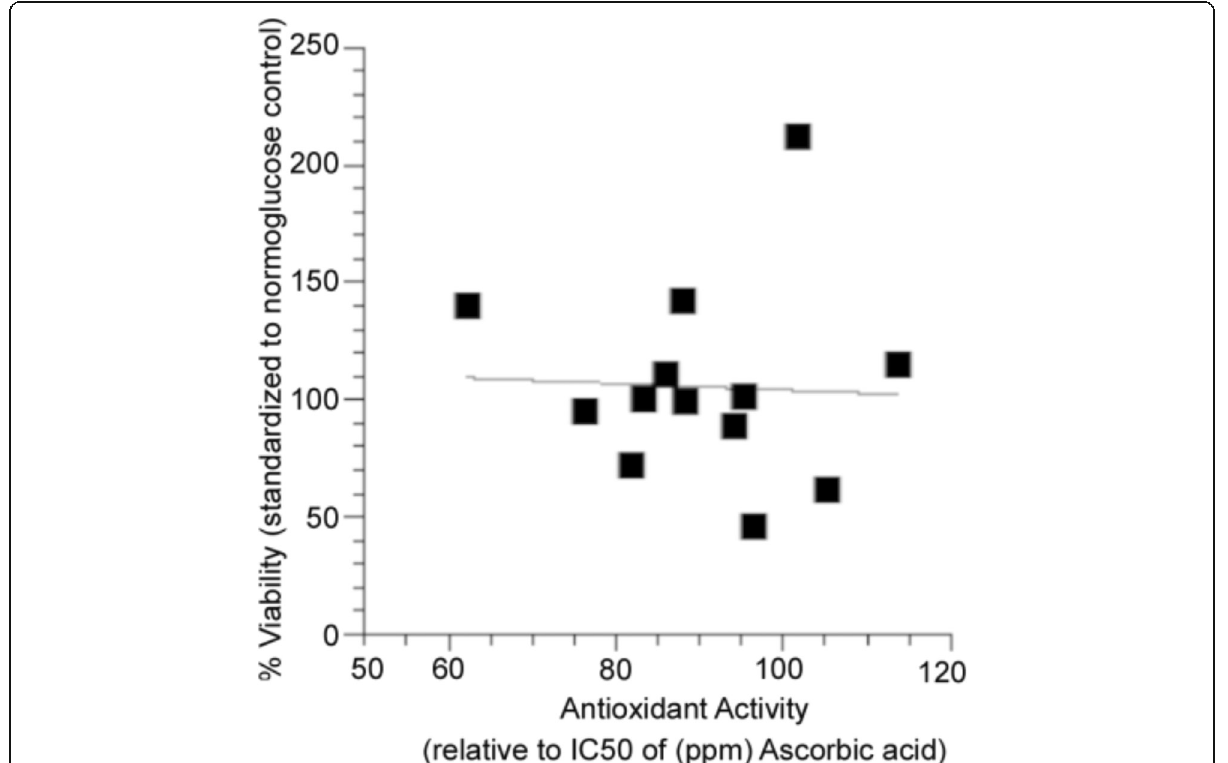
Fig. 7 Regression analysis of antioxidant activity of P. mariana extracts with respect to PC12-AC bioactivity in high glucose media. Antioxidant activity is measured with respect to ascorbic acid and bioactivity is represented as percent viability with respect to normoglucose control. We do not see any trend; therefore, the antioxidant activity is not likely the main mechanism of protection ( p = 0.89, n =